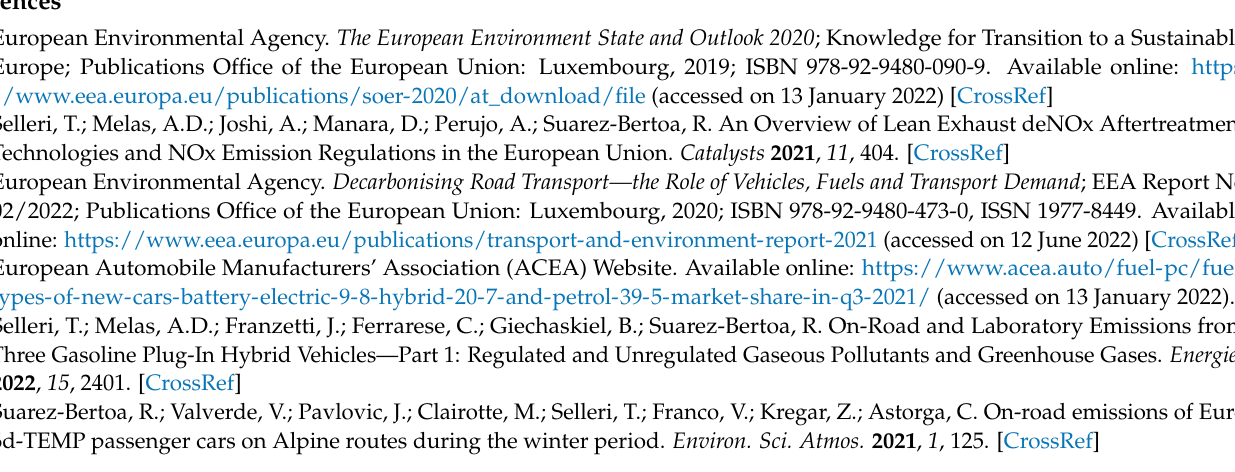
Figure S1—Profiles of speed and slope (when relevant) for laboratory cycles. Examples of speed and altitude profiles for on-road routes. Figure S2—Experimental set-up used during the tests performed at VELA 8 laboratory (top) and on-road (bottom). Figure S3—Emissions of NOx during CD4 of the WLTP. Figure S4—Emissions of NOx during two RDE test with initial SOC equals to 100. Figure S5— Emissions of NOx during CD (top) and CS (bottom) of the WLTP at − 10 ◦ C. Figure S6—Emissions of NOx during BAB test at − 10 ◦ C. Figure S7—Emissions of NOx during highway tests (Motorway route (bottom) and BAB